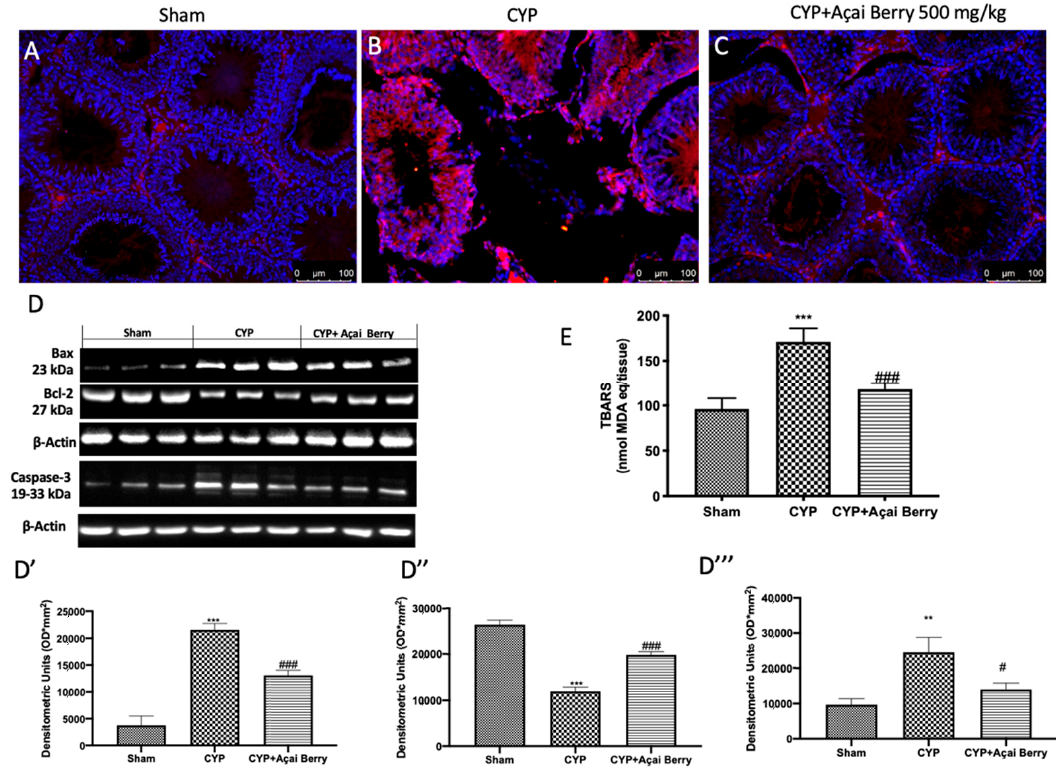
Figure 8. Açai berry administration limits CYP-induced apoptosis and TBARS in testes. Representative TUNEL photos of ( A ) sham, ( B ) CYP, and ( C ) açai berry treatments. Western blots and quantification of testicular tissue for ( D ) Bax, Bcl-2, and caspase 3 and respectively densitometric analysis ( D’ , D’’ , D’’’ ) . ( E ) TBARS quantification in testes. ** p < 0.01 vs. sham; *** p < 0.001 vs. sham; # p < 0.05 vs. CYP; ### p < 0.001 vs. CYP.